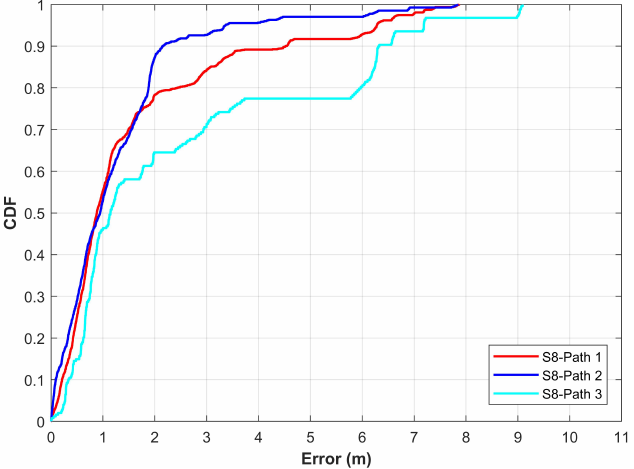
Figure 13. The CDF graphs for various path geometries used to evaluate the performance of magnetic field-based indoor positioning